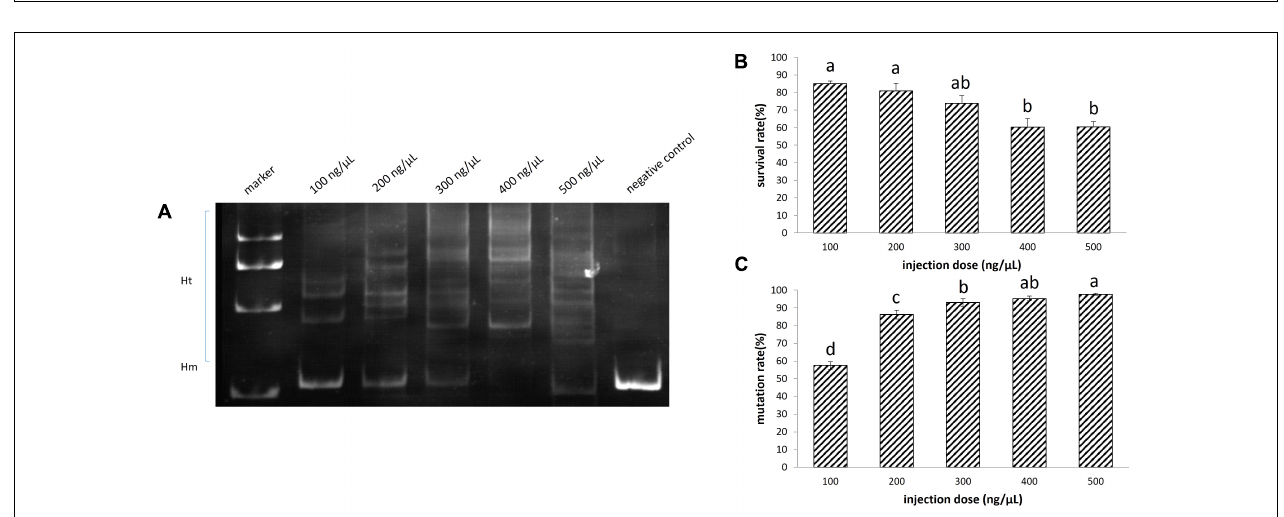
FIGURE 2 | (A) Detection of EGFP by fluorescence in embryos at 2 dpf. (B) Detection of EGFP by fluorescence in embryos at 8 dpf.